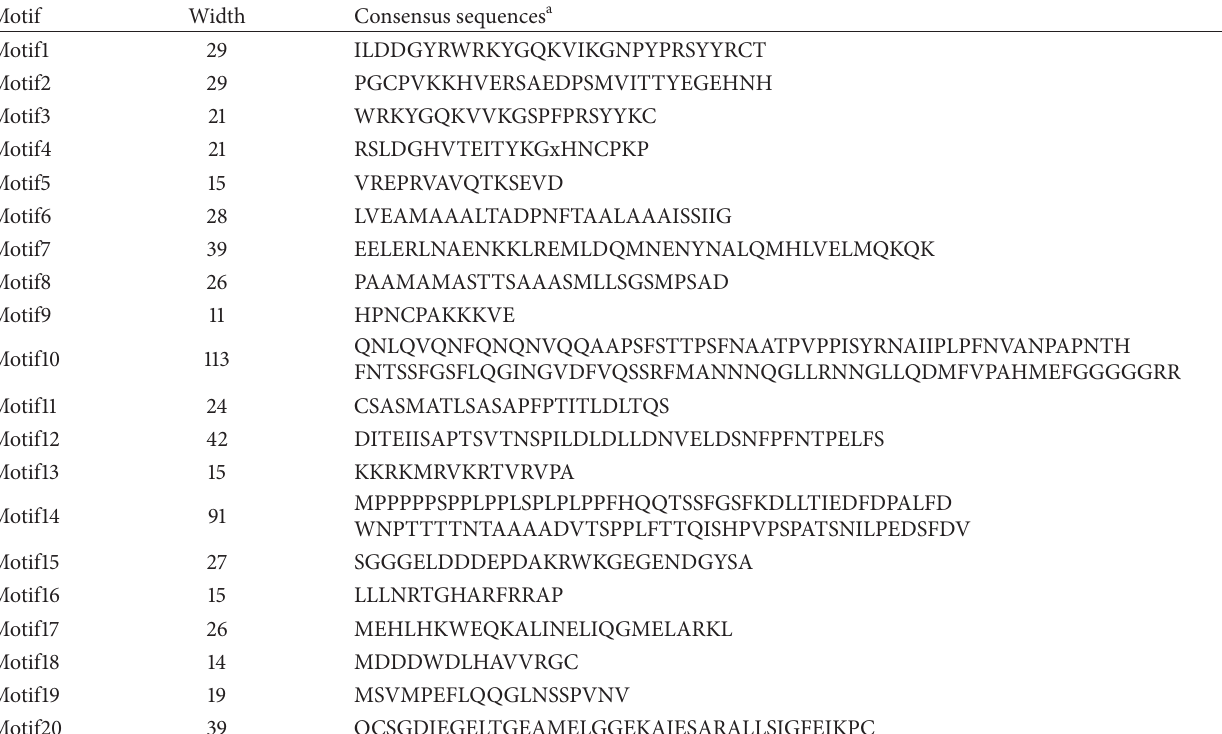
Table 3: Consensus sequences of WRKY motif in Lotus japonicus